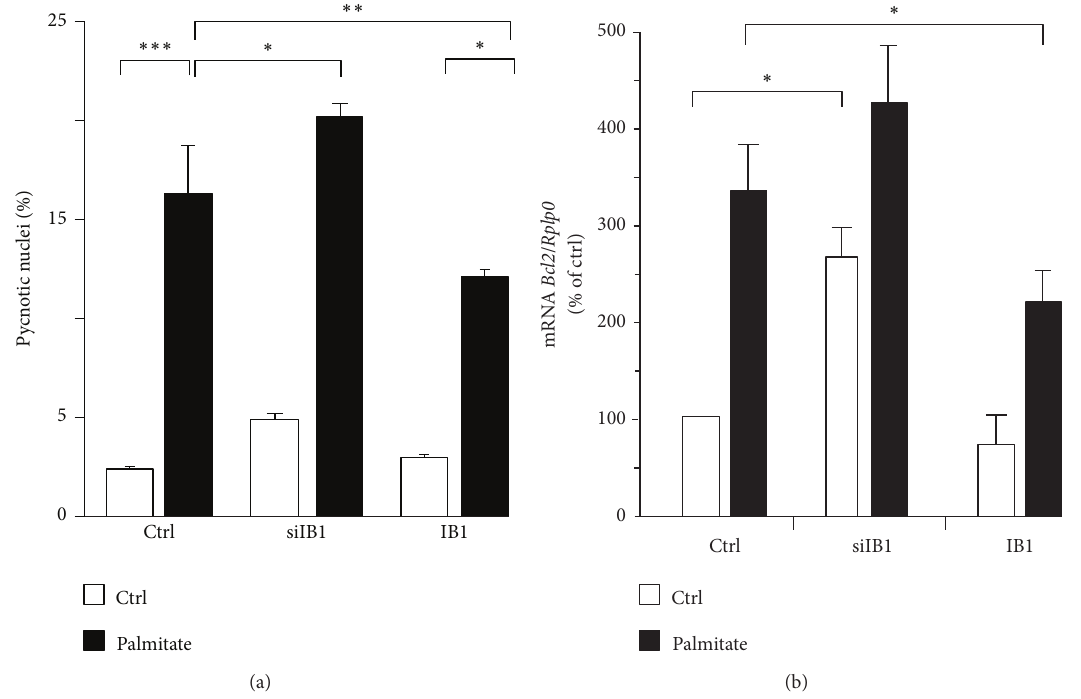
Figure 4: Role of Ib1 in apoptosis induced by palmitate. (a) MIN6 cells were transfected with the siRNA duplex directed against IB1 (siIB1) or control siRNA (siGFP, Ctrl) or the plasmids coding for the wild type HA-tagged IB1 (IB1). For scoring death, 0.5 mM palmitate ( filled bars ) or BSA (Ctrl, open bars ) was added to the cells medium 24 hrs after transfection. The rate of apoptosis was scored by counting pycnotic nuclei in cells exposed for 48hrs to palmitate. Results are expressed as mean ± SEM of 3 independent experiments ( ∗ 𝑃 < 0.05 ; ∗∗ 𝑃 < 0.01 ; ∗∗∗ 𝑃 < 0.001 ). (b) For the quantification of Bcl2 , total RNA from transfected cells with siGFP, siIB1, and IB1 was prepared and subjected to qPCR. The levels of Bcl2 were compared in cells incubated with BSA ( open bars ) and 0.5 mM palmitate ( filled bars ) for 48 hrs. The mRNA were normalised against Rplp0 and those of the control cells were set to 100%. Data are the mean ± SEM of five independent experiments ( ∗ 𝑃 < 0.05